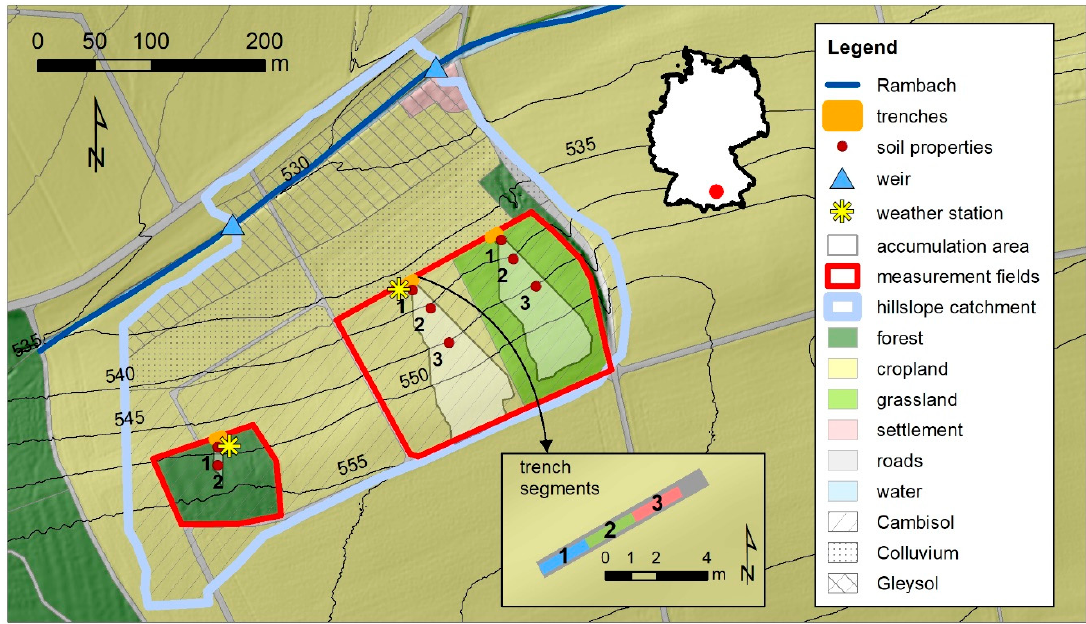
Figure 1. Overview of the measurement setup: locations of the three trenches within the Rambach subcatchment, including positions of soil moisture measurements and accumulation areas; the zoom-in shows a detailed view of the trench, which is divided into three segments.